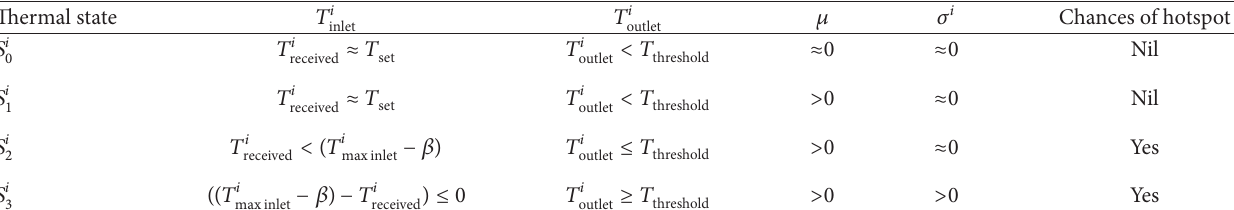
Table 1: Domain table for thermal states.